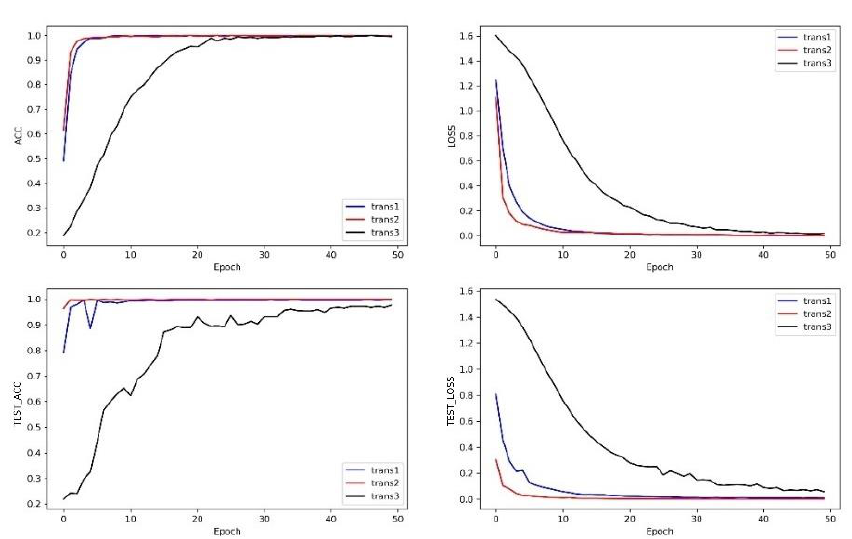
Figure 13. Comparison of three transfer methods under 0.625 data size.